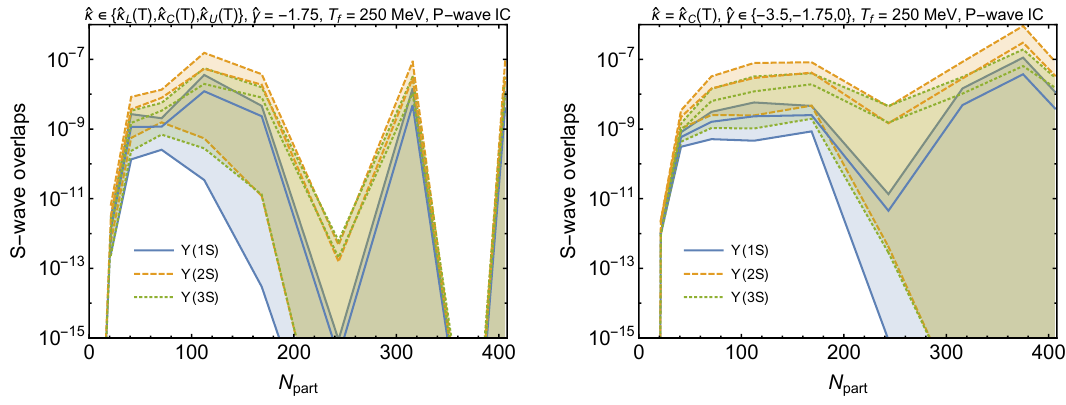
Figure 13 . Quantum-mechanical overlaps with singlet S -wave states obtained using singlet P -wave initial conditions. The bands shown in the left and right panels correspond to the variations detailed in the caption of figure 6. In both panels, the central line shows the result averaged over the corresponding